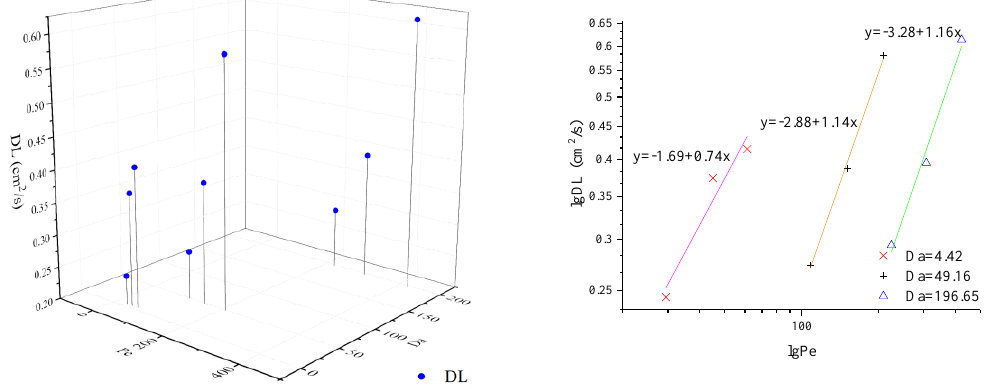
Figure 5. DL under different value of Pe and Da.